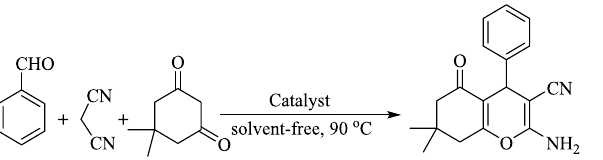
Figure 15. Role of the catalyst in the synthesis of 2-amino-3-cyano-4 H -chromene from benzaldehyde.